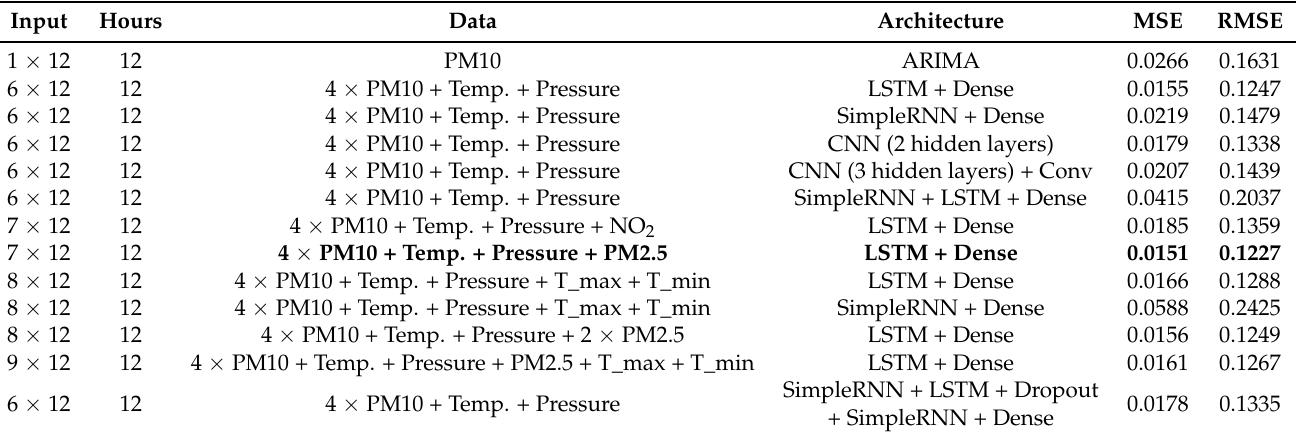
Table 5. Summary of the evaluated approaches with the achieved average forecasting performance in terms of Mean Squared Error (MSE) and Root Mean Squared Error (RMSE) for the 12 h time horizon. The best performance is marked in bold.